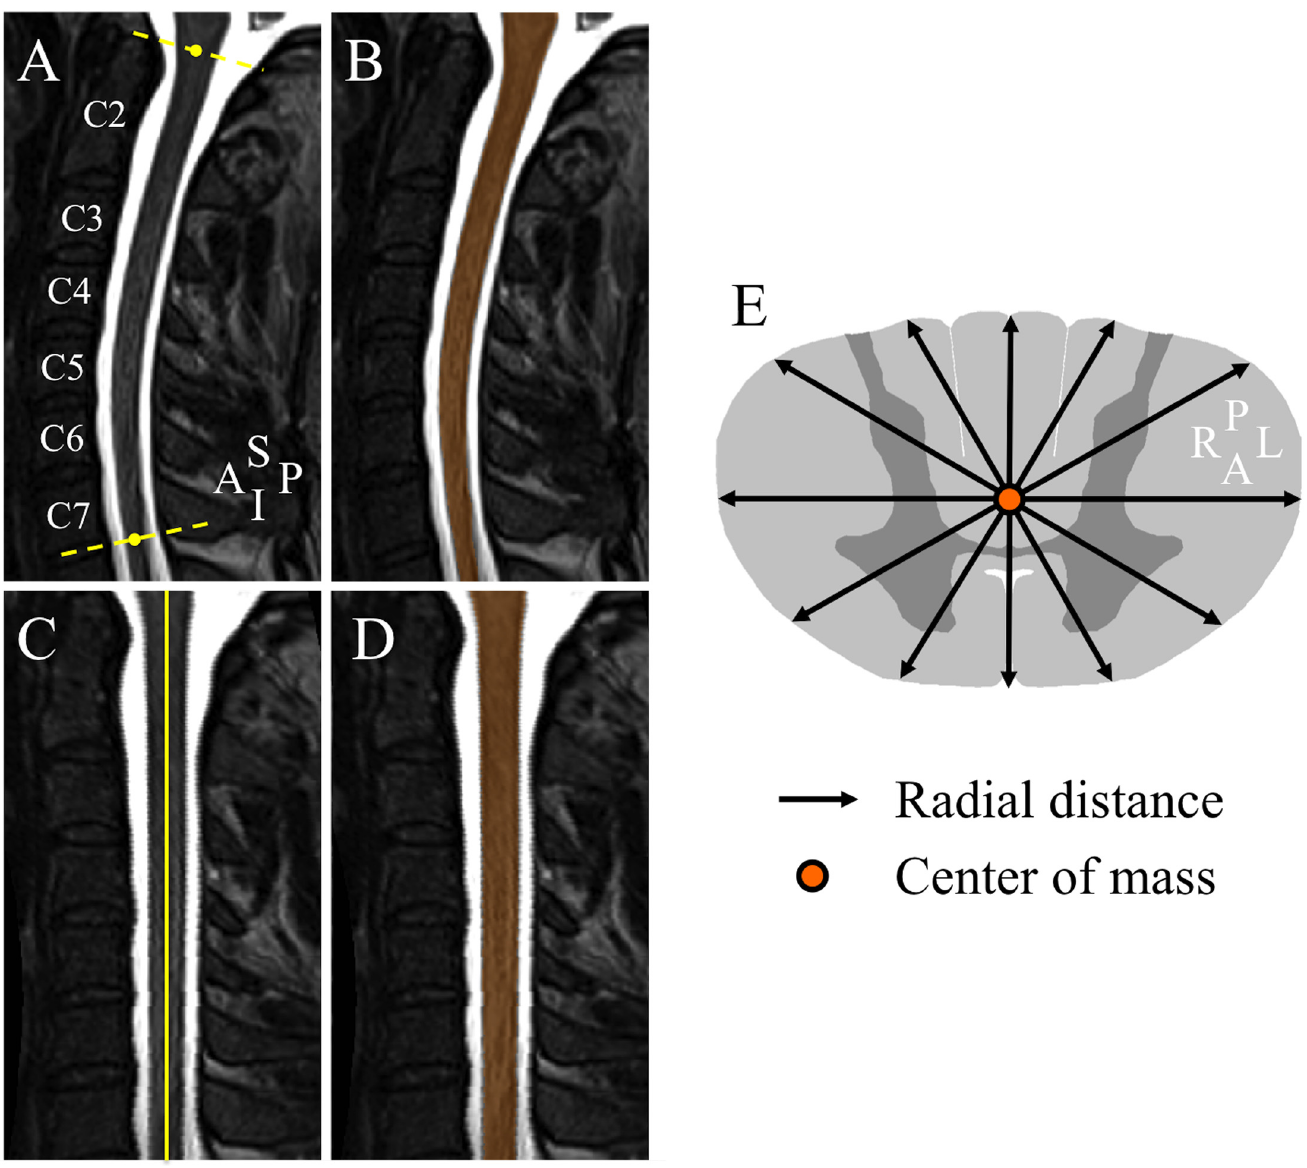
Fig 1. Spinal cord segmentation, cord straightening and radial distance illustration. (A) Preprocessed T2-weighted mid-sagittal section in an SMA patient. The yellow dashed lines delimit the cervical spinal cord region. (B) Resulted segmentation mask (orange). (C) Cervical spinal cord straightening. (D) Mask straightening (orange). (E) Radial distance measurements. A, anterior; I, inferior; L, left, P, posterior, R, right, S,